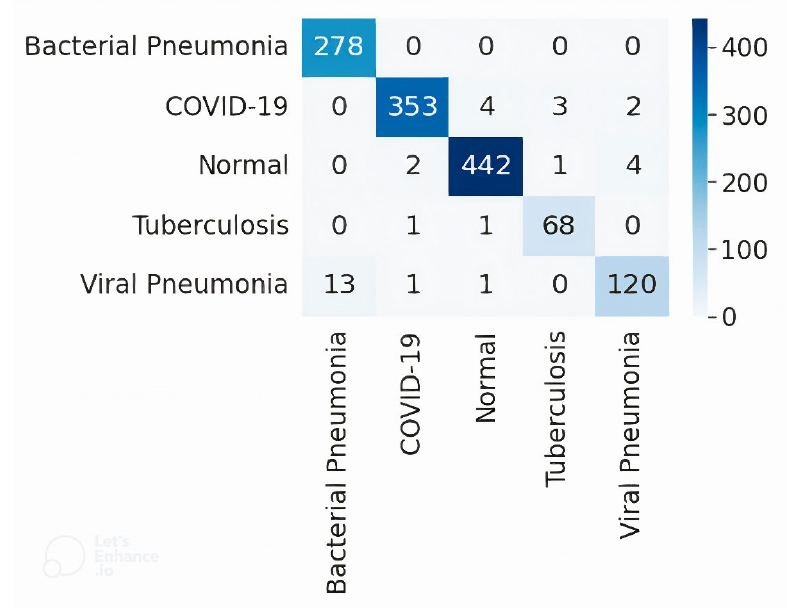
Figure 22. Confusion matrix for five ‐ class classification by the Xception model.